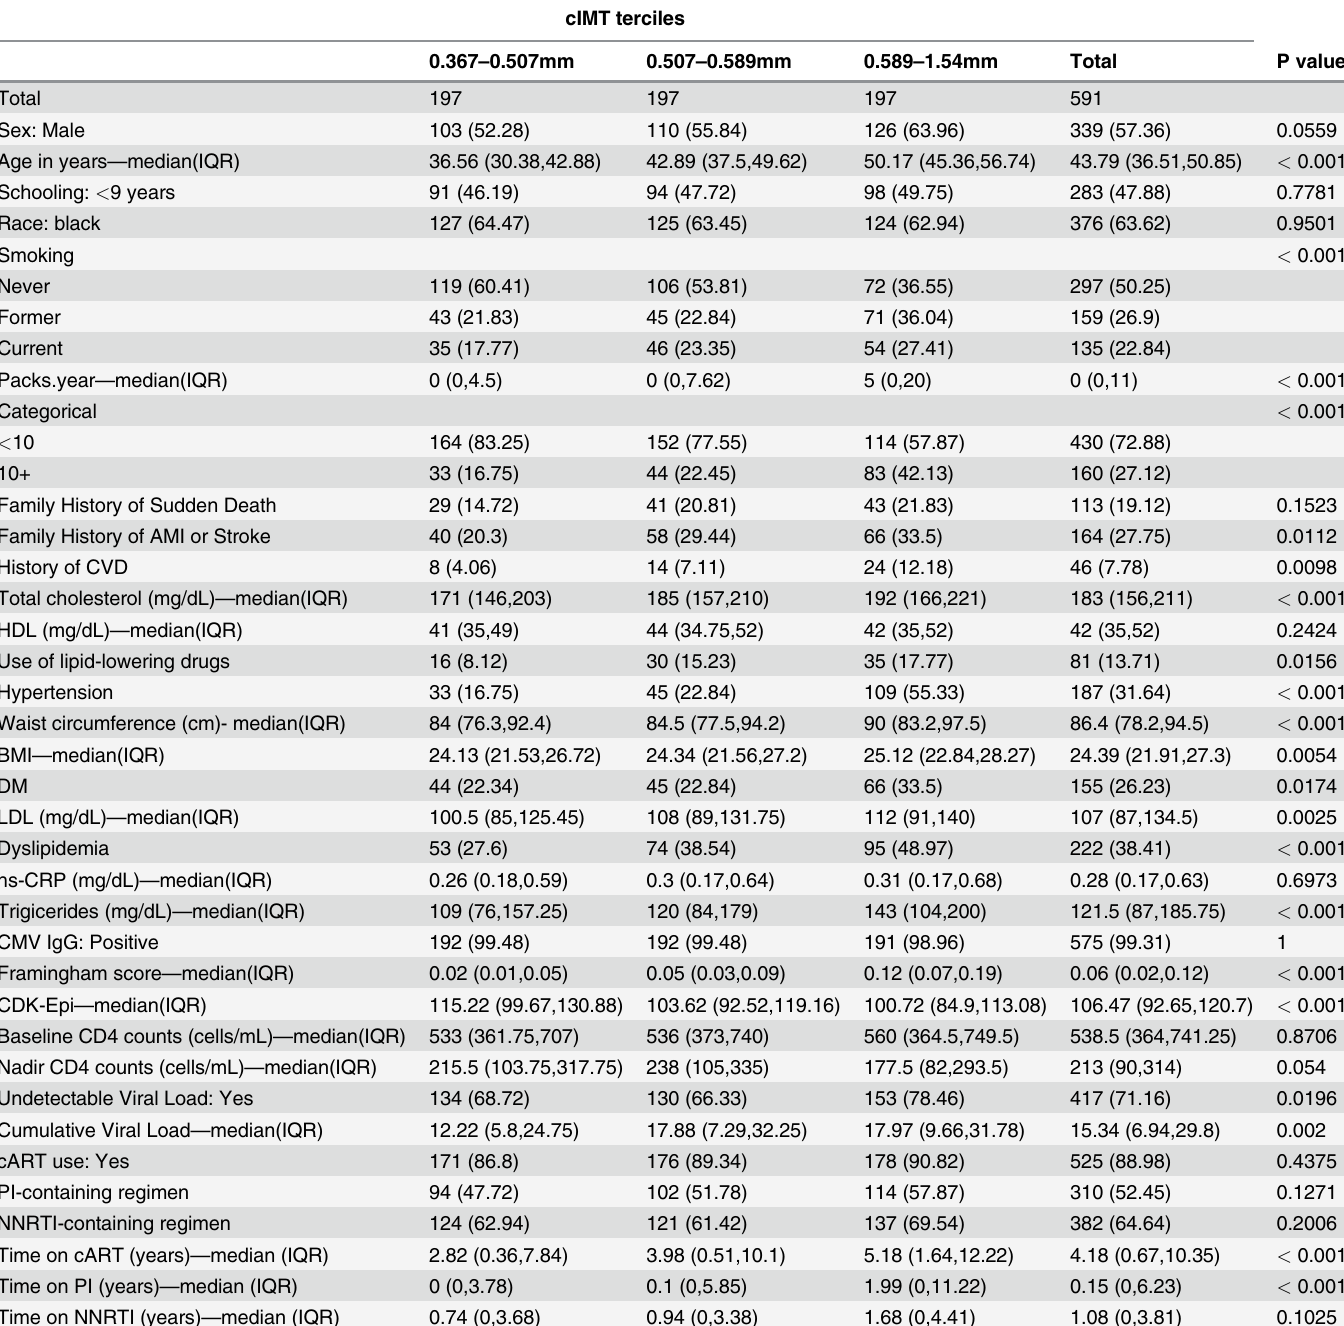
Table 1. Characteristics of patients strati fi ed by cIMT terciles a